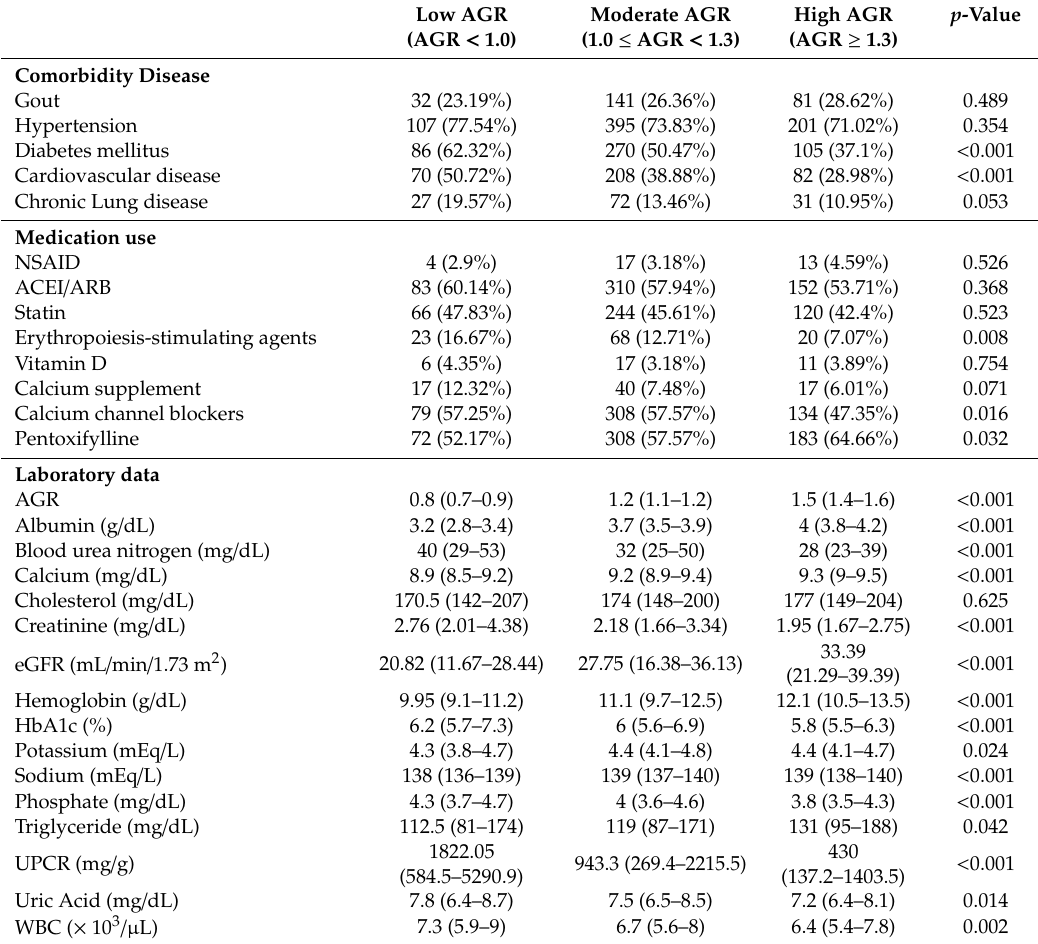
Table 2. Baseline characteristics of the study population by the AGR